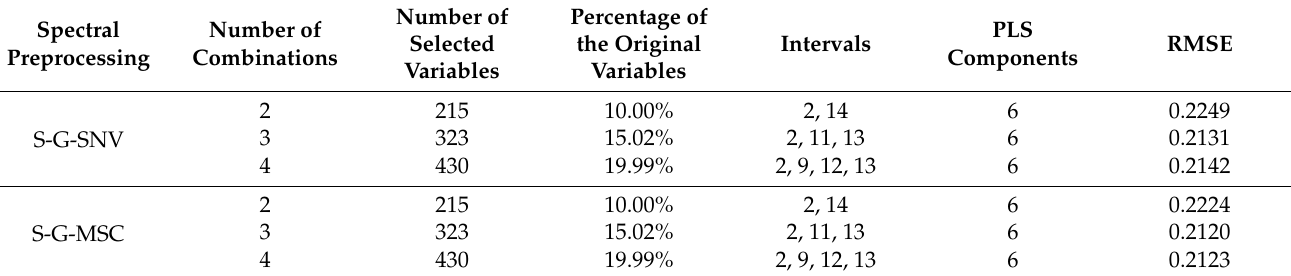
Table 5. Band optimization results of two pretreated spectra by SiPLS.